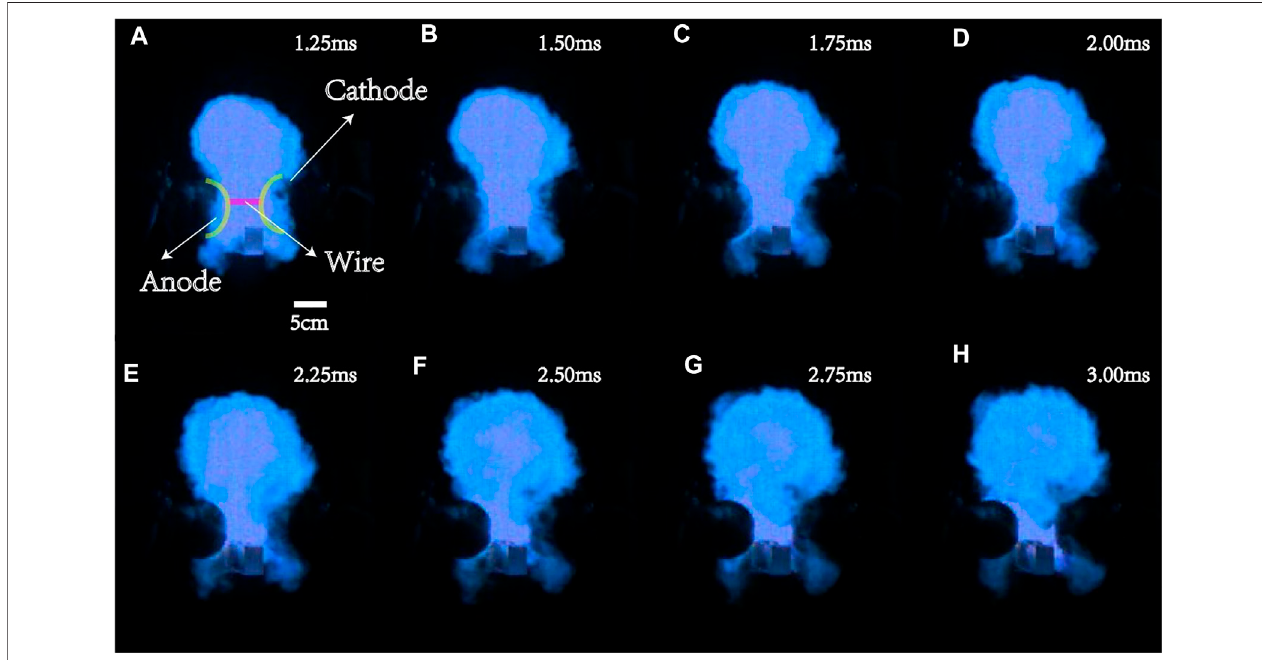
FIGURE 3 | Time-series images of plasma jet evolution for experiment 2. The solid lines show the position of the electrodes in the fi rst image, and the plasma instability is not observed.